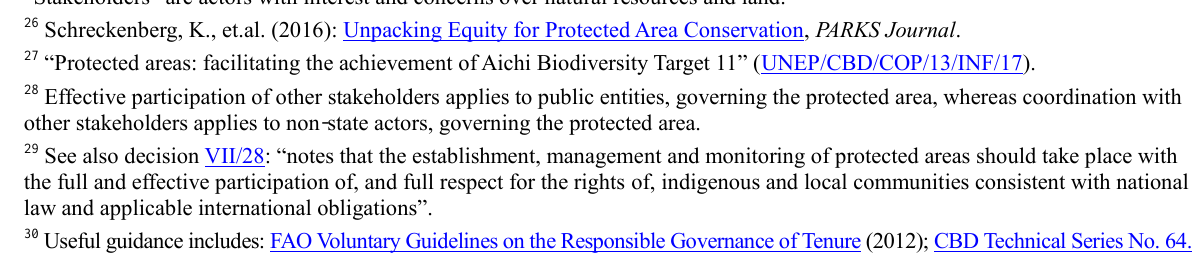
Source : Adapted from McDermott et al. (2013). Examining equity: A multidimensional framework for assessing equity in payments for ecosystem service . Environmental Science and Policy 33: 416-427 and Pascual et al. (2014). Social equity matters in payments for ecosystem services. Bioscience 64(11)